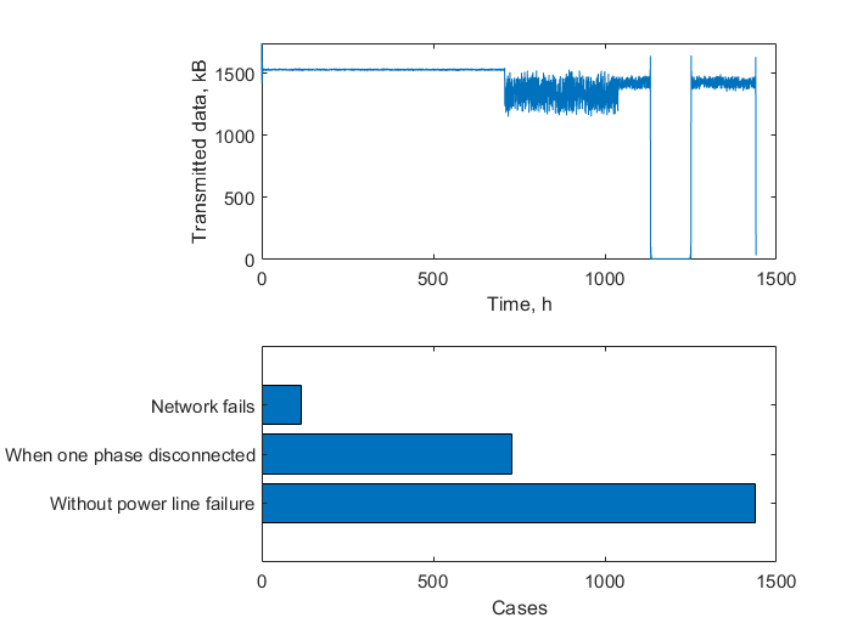
Figure 11. The results of size of transmitted data related to the transmissions